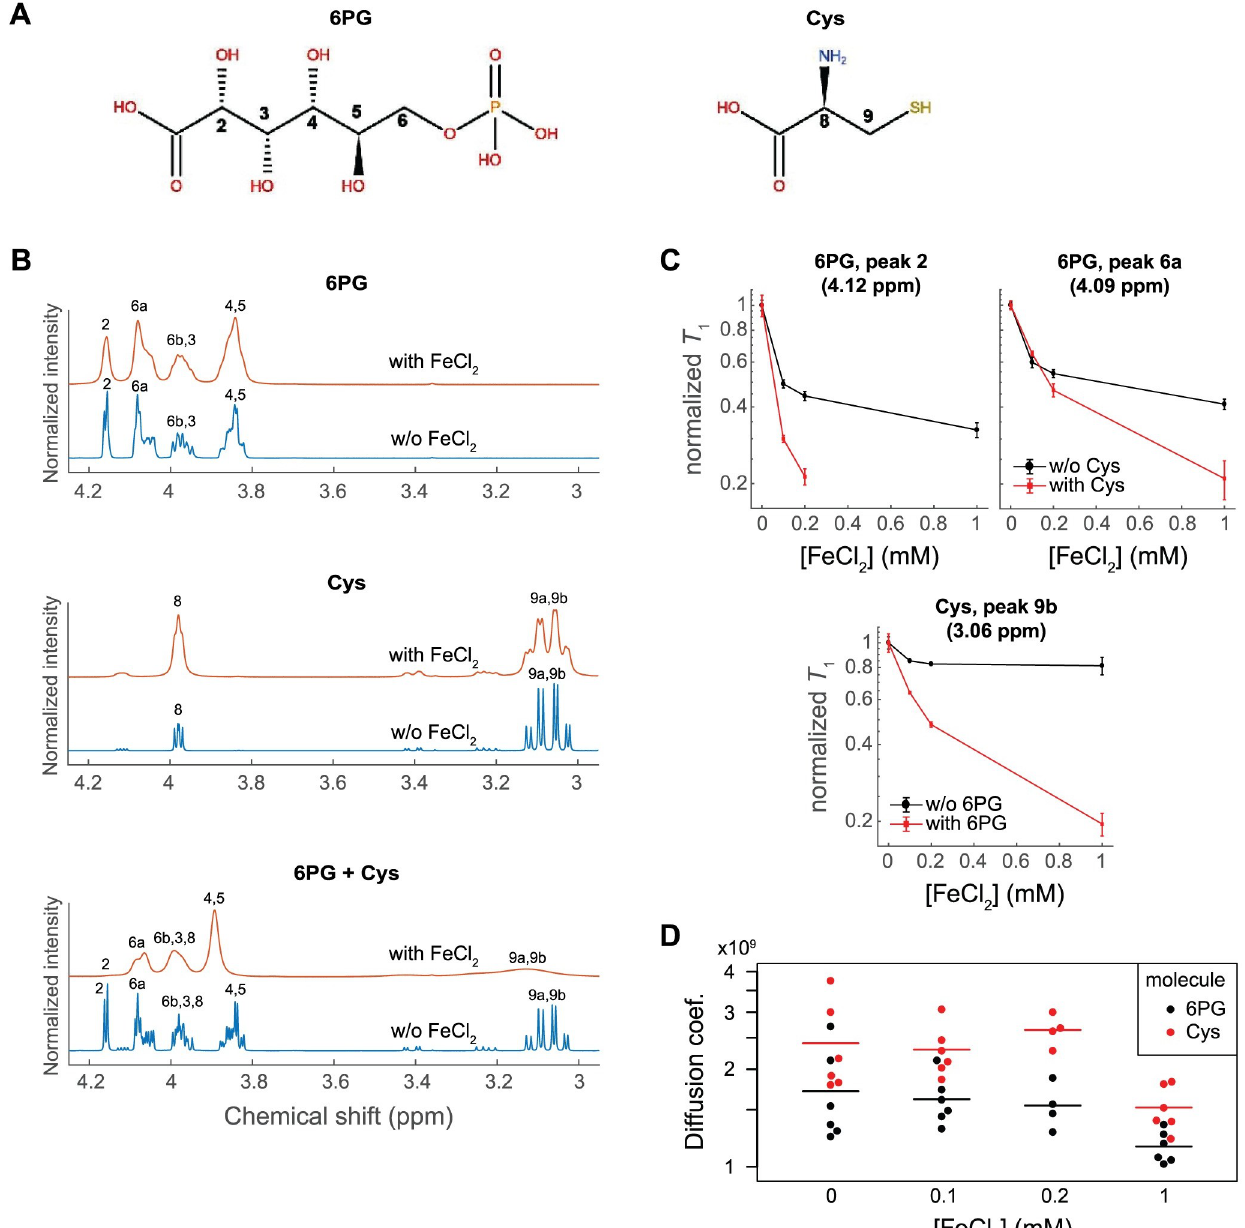
Fig 3. Complementary interactions of cysteine and Fe(II) with 6PG. (A) 6-phosphogluconate and cysteine molecular structures, indicating positions of resonant protons. (B) Representative 1 H-NMR spectra of 6PG alone, cysteine alone, or the combination of both (20 mM of each analyte) in 50 mM phosphate pH 5/D 2 O solutions, either in the absence or presence of 1 mM FeCl 2 . Peak numbers correspond with proton labels in (A). The massive disruption and suppression of the 1 H signal peaks upon addition of Fe(II) to the binary mixture suggests a coordination between cysteine and 6PG in Fe(II) binding. Spectra are shown normalized to the maximum peak intensity per spectrum ( N � 3) (see S1 Data). (C) T 1 relaxation time scaling of 6PG resonant protons near carboxylic (peak 2; 4.12 ppm) and phosphate (peak 6a; 4.09 ppm) groups and cysteine proton (peak 9b; 3.06 ppm) signals with increasing Fe (II) concentrations when analyzed separately versus in combination (conditions as in (B)). Data shown as mean ± SD from N = 3 independent experiments (see S1 Data). (D) Diffusion coefficients measured by DOSY for cysteine and 6PG molecules (20 mM each) when co-incubated with a mixture of increasing concentrations of Fe(II) and constant, saturating concentrations of phenanthroline, a strong, nonchelating Fe-binding complex. Both molecules showed a noisy but significant decrease in diffusion, a further indication of Fe(II) binding. Individual measurements (dots) and mean (horizontal line) from N � 4 experiments (see S1 Data). 6PG, 6-phosphogluconic acid; DOSY, diffusion ordered spectroscopy; R5P, ribose-5-phosphate.